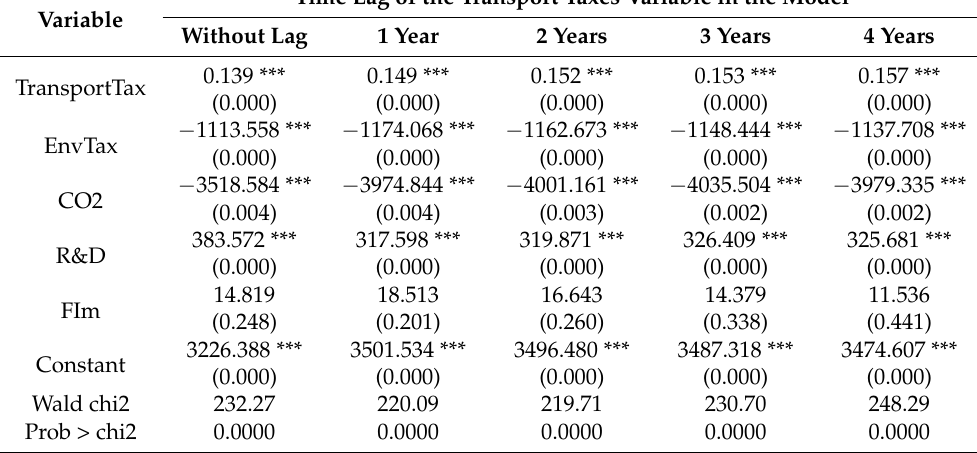
Table 4. Results of the assessment of transport taxes impact on the biofuel consumption in the European countries for 2010–2020.